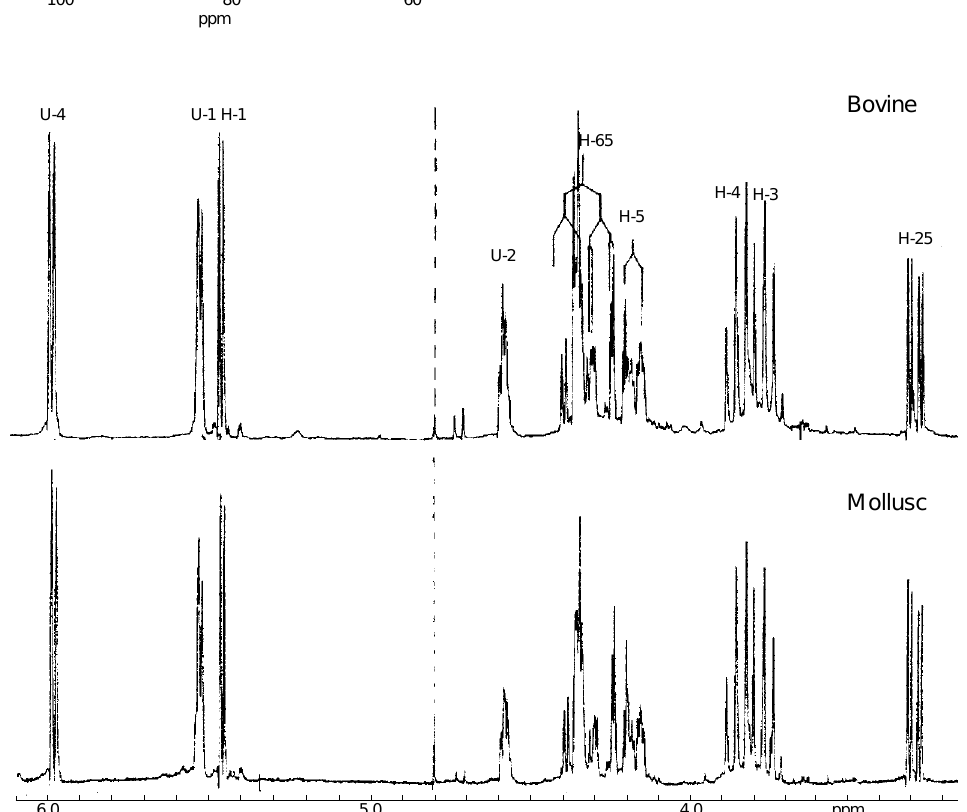
Figure 11 - [ 1 H]-NMR of IdoA,2S- GlcNS,6S formed from mamma- lian and mollusc heparin by ac- tion of heparinase. Upper panel, Mammalian heparin; lower panel, mollusc